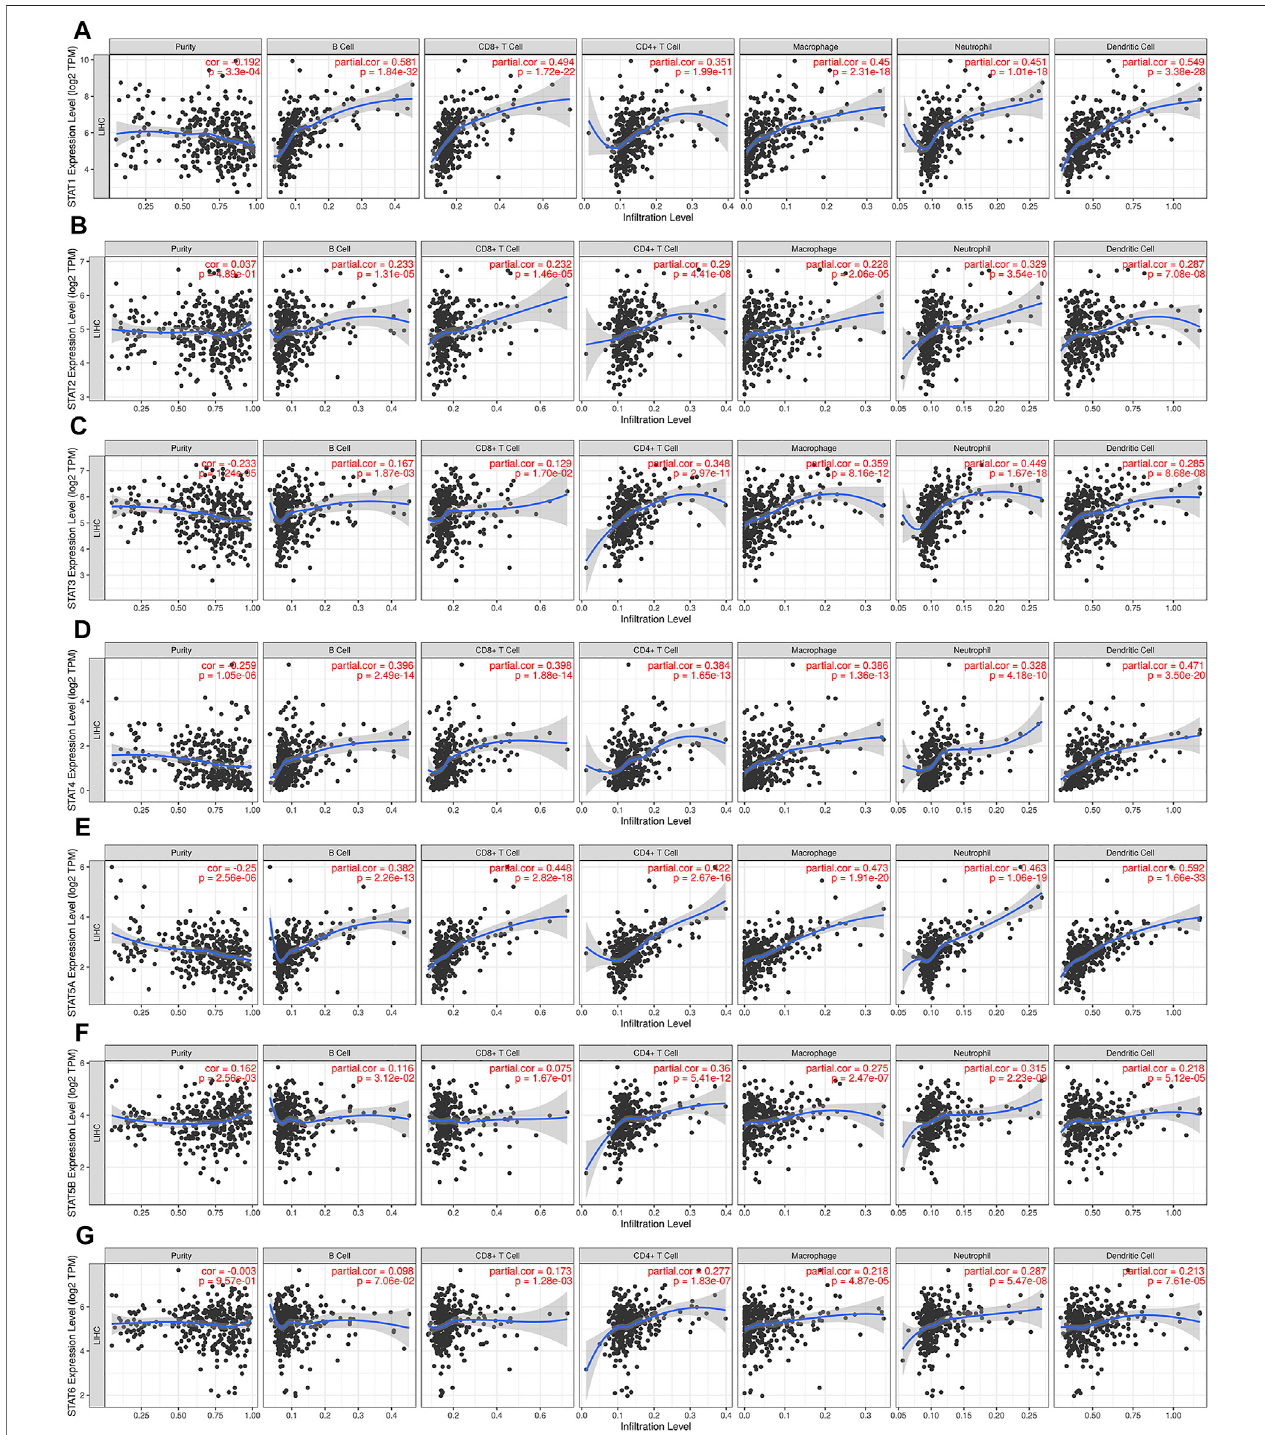
FIGURE7| RelationshipbetweenSTATfamilyexpressionlevelsandimmunein fi ltrationlevelsinHCC(TIMER).Correlationbetweentheabundanceofimmunecells and the expression of (A) STAT1, (B) STAT2, (C) STAT3, (D) STAT4, (E) STAT5A, (F) STAT5B, and (G) STAT6 in HCC.